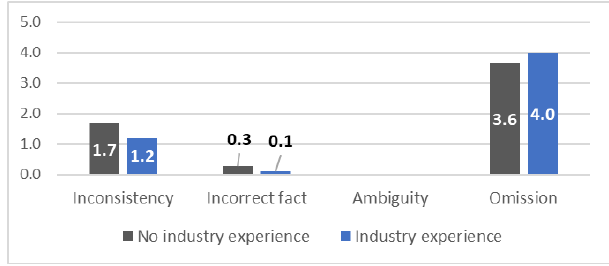
Fig. 11. Mean of the number of defects per type in mockups.